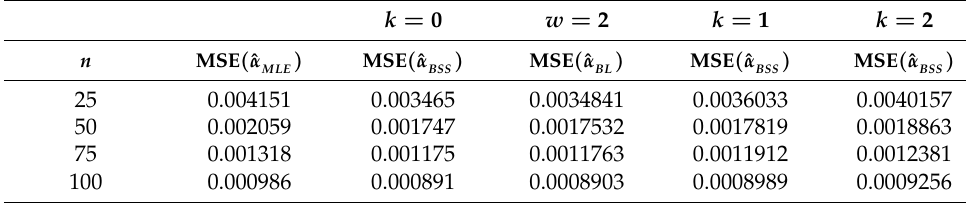
Table 2. Simulated MSE of ˆ α using Uniform b over [0, 1], β = 3, u = 4 and v = 5.